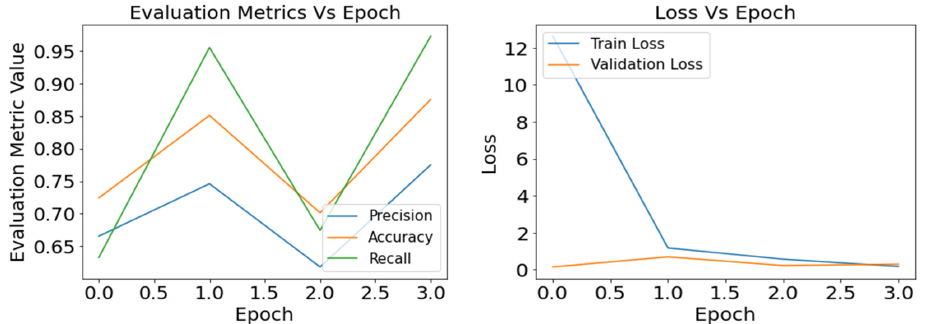
Figure 7. Defects classification with InceptionV3: result of the evaluation metrics and model loss for optimizer SGD and learning rate 0.0001.